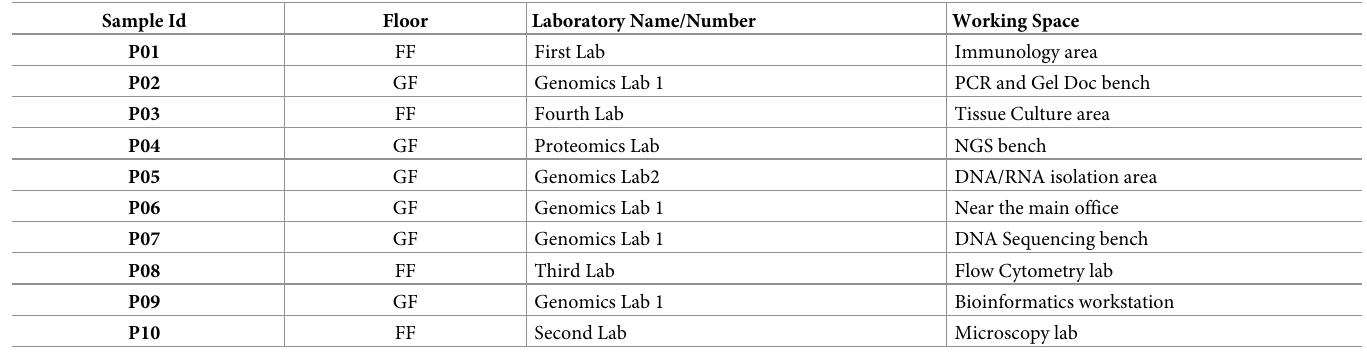
Table 2. Working area of ten health care professionals sampled at three different time points. Sample